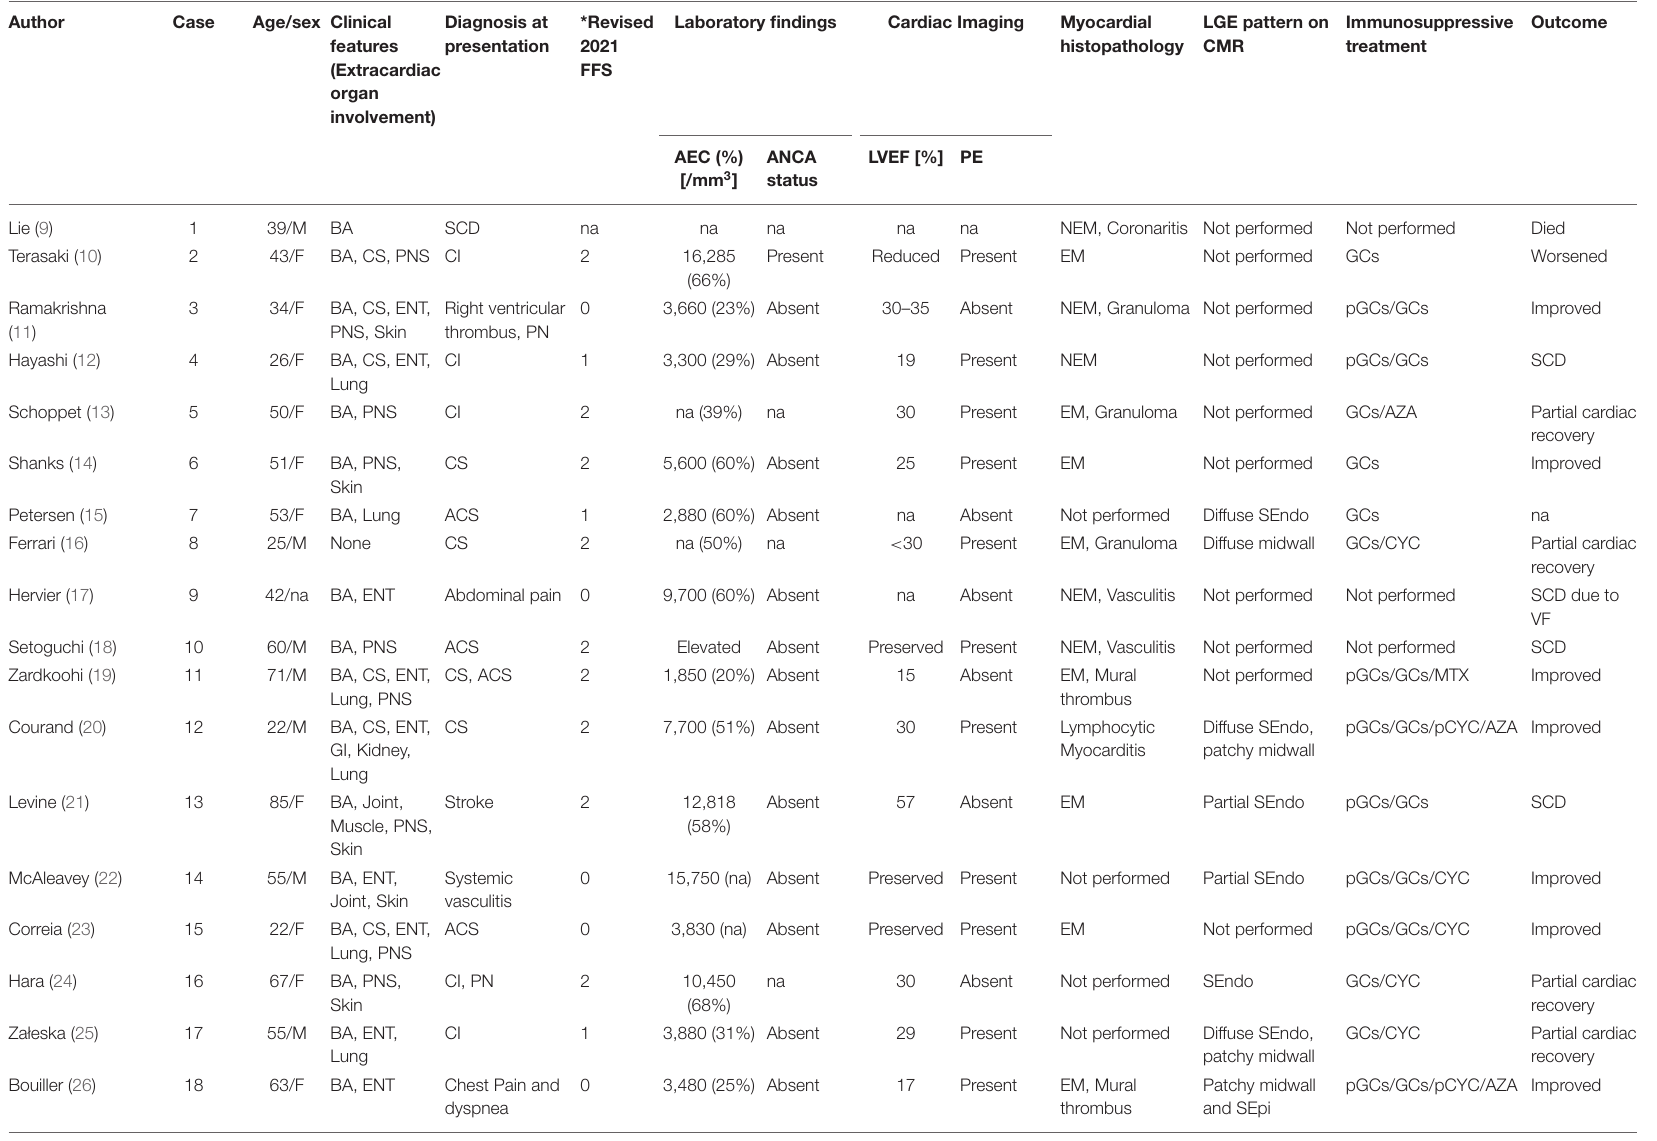
TABLE 1 | Cases of EGPA-associated